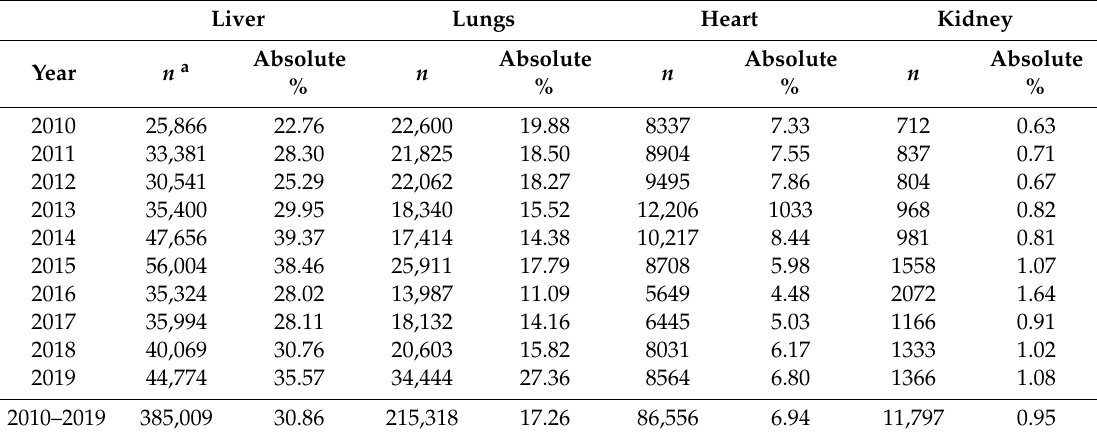
Table 3. Details of the frequencies of the most condemned organs per year and for the total period (2010–2019). n : number of